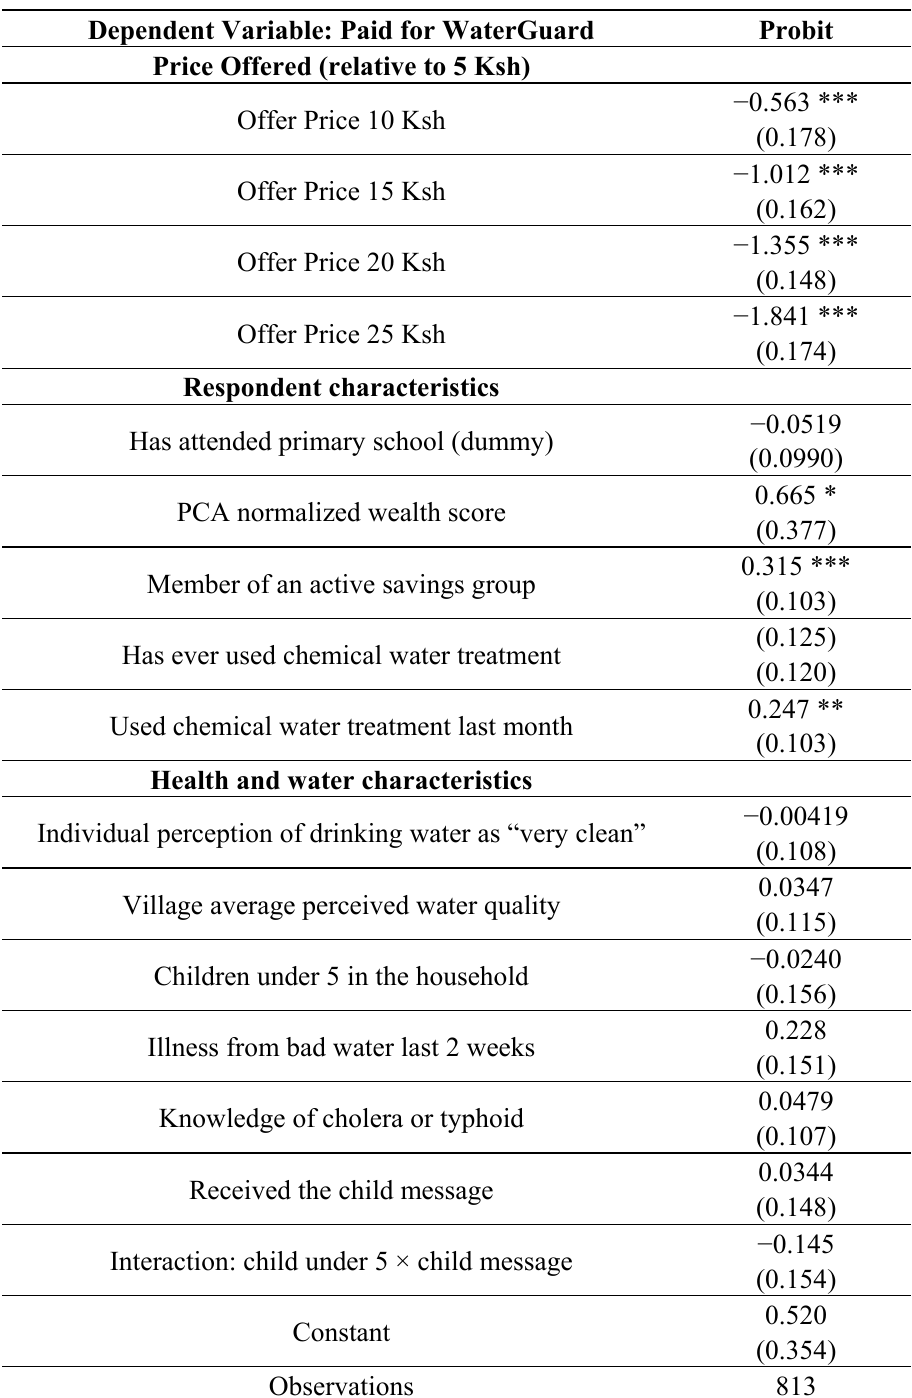
Table 3. Full probit regression model for the purchase of